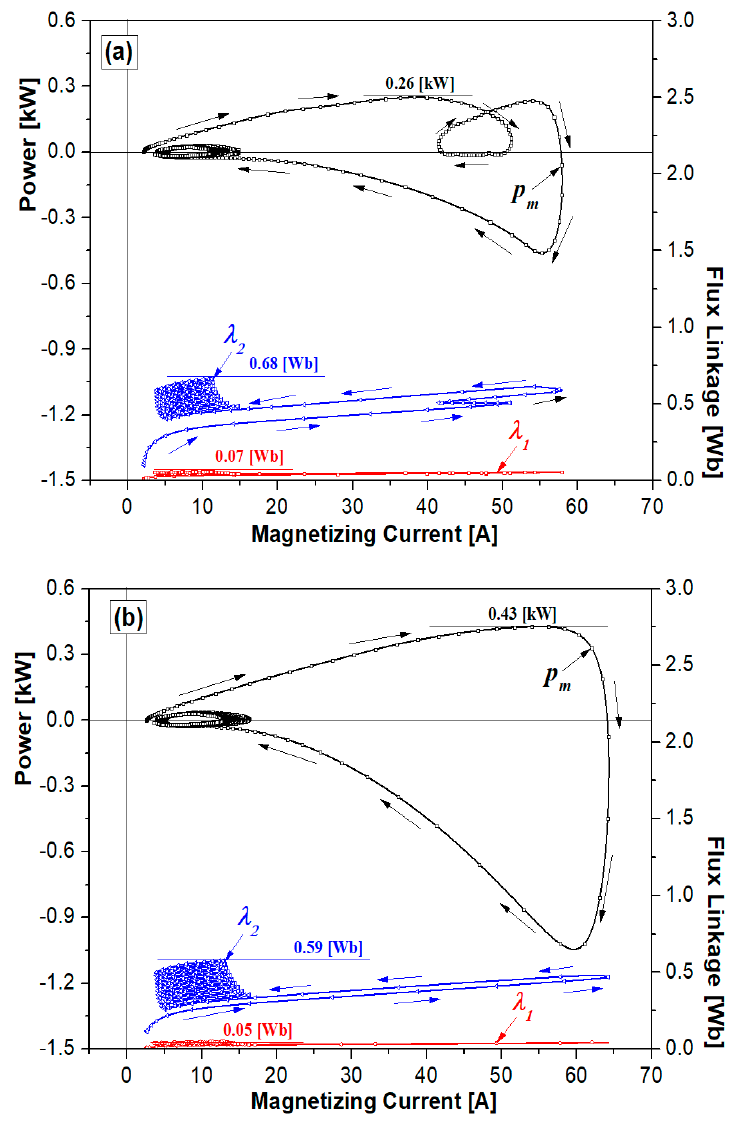
Figure 8. Variation of magnetization power ( p m ) area and flux linkage’s ( λ ) operational range dependent on the magnetizing current ( i m ) during fault period in the bridge type SFCL using flux-coupling according to the change of input voltage source. ( a ) E in = 80 V rms . ( b ) E in = 100 V rms